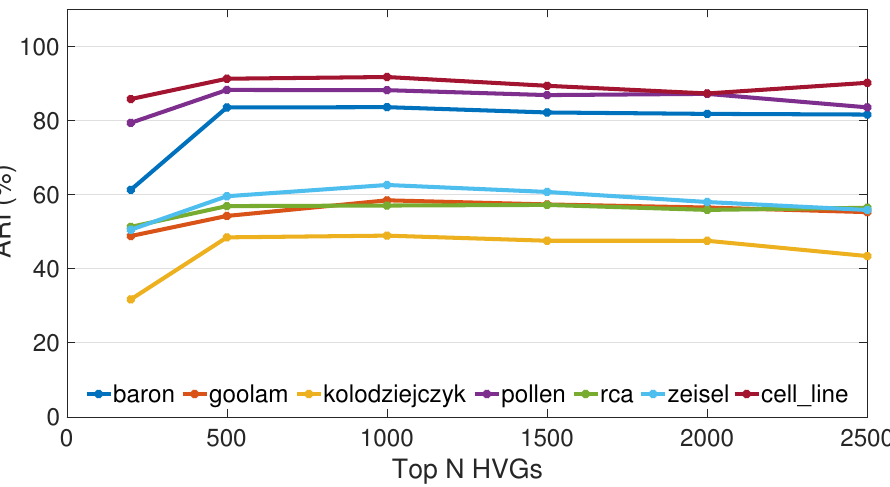
Figure 3. The clustering performance (ARI) with different high variable genes (HVGs). Each broken line represents the ARI of a dataset with 200–2500 high variable genes.